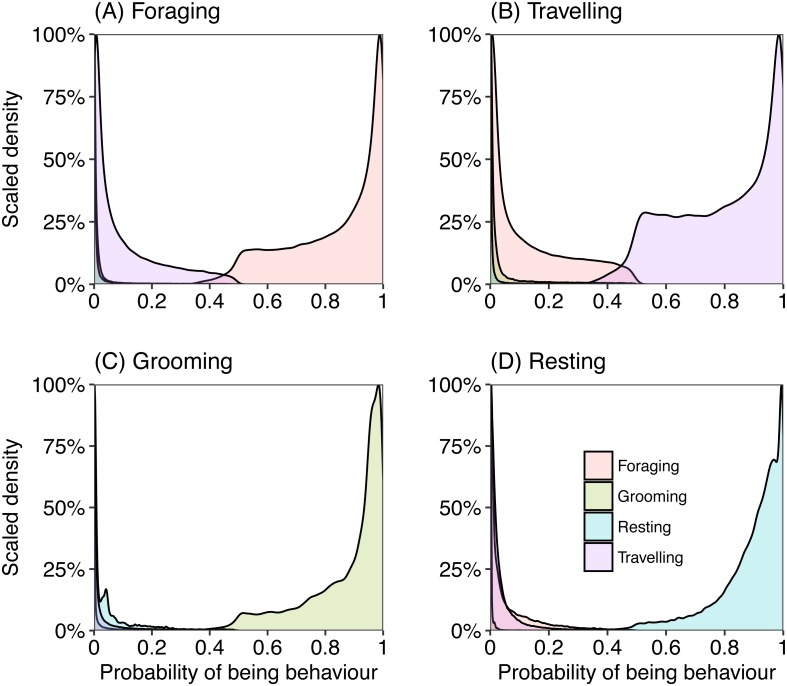
Density plots representing the probability of an epoch belonging to behavioural category (A) foraging, (B) travelling, (C) grooming and (D) resting, calculated from captive data.Each plot represents the probability of belonging to a behavioural category when the labelled category was predicted as the most likely class for that epoch.